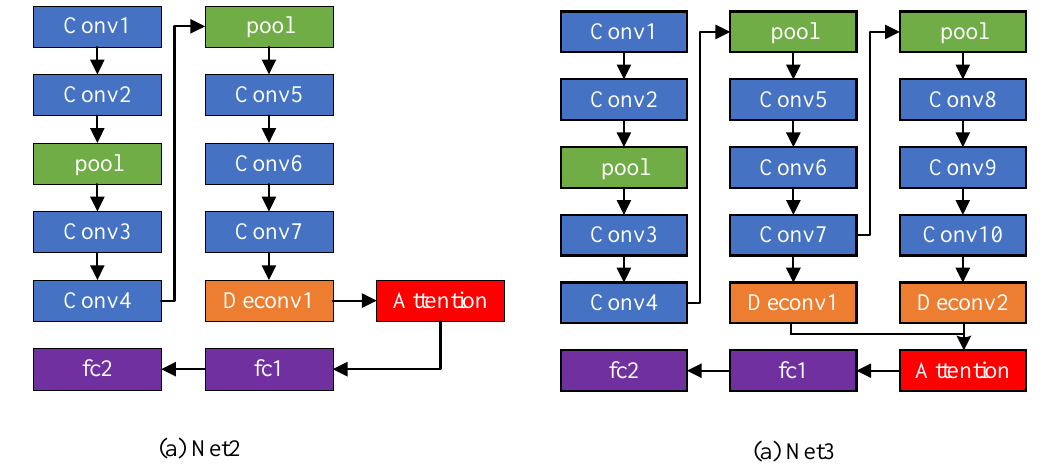
Figure 9. The structure of Net2 and Net3. Table 7. Performance of feature fusion.